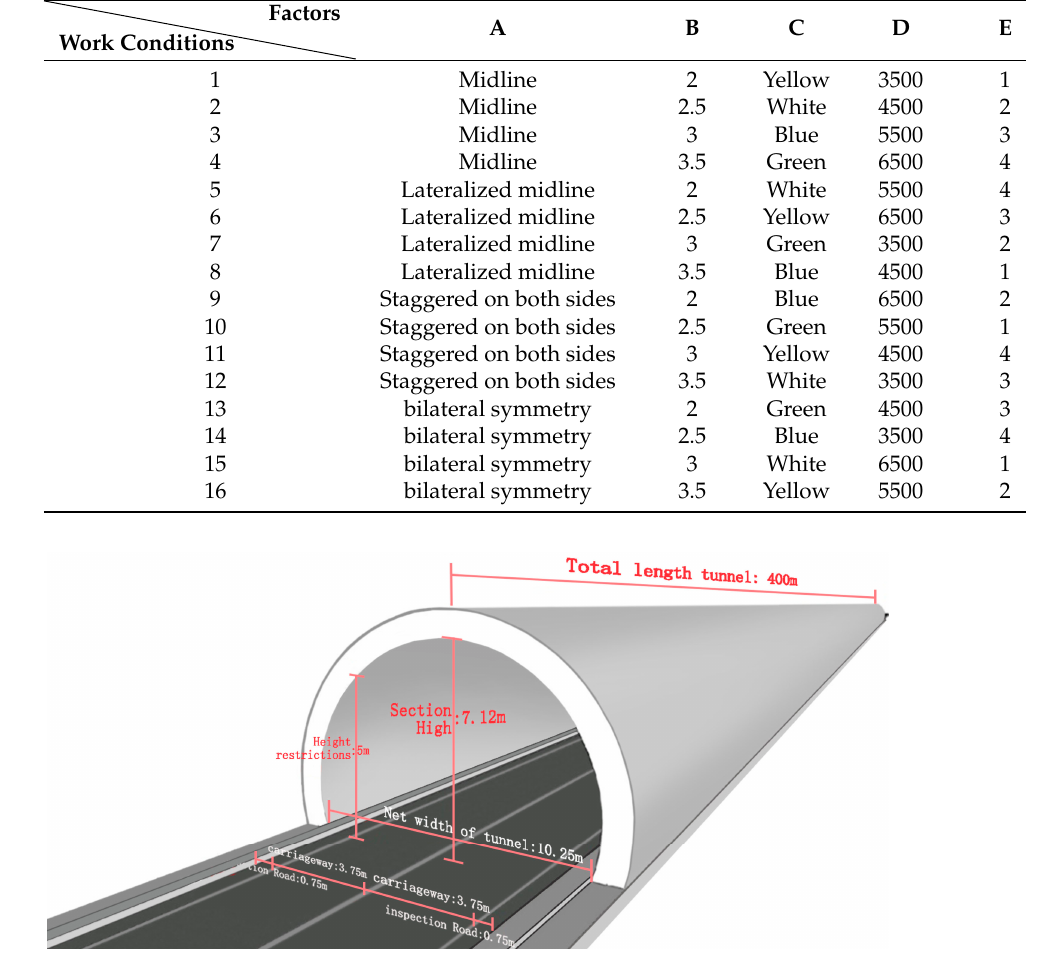
Table 3. Lighting test program.